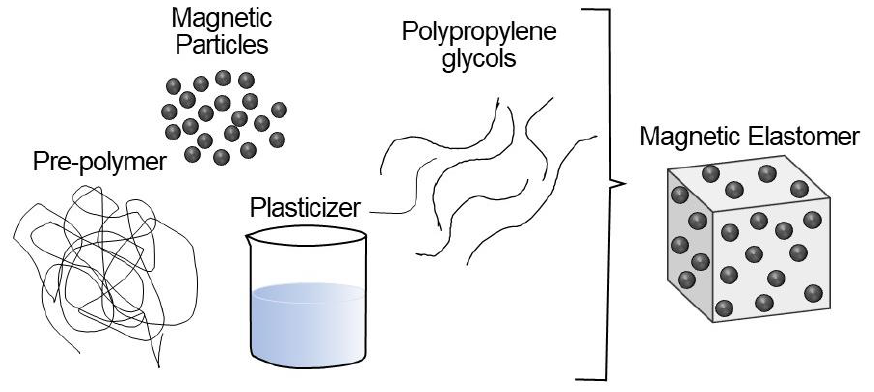
Figure 6. Schematic illustration showing the sample preparation for magnetic elastomers.